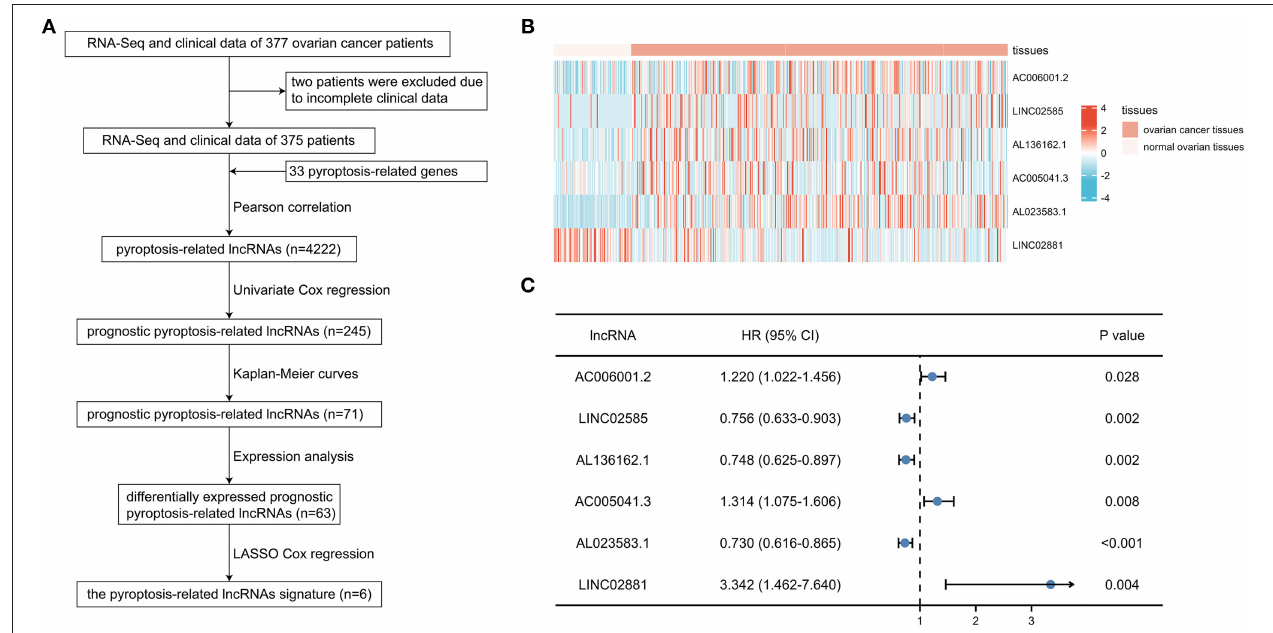
FIGURE 1 | Identification of prognostic pyroptosis-associated long noncoding ribonucleic acids (lncRNAs) in patients with ovarian cancer (OC). (A) Flow chart of constructing the pyroptosis-related lncRNAs signature. (B) Heatmap of 6 prognostic pyroptosis-related lncRNAs in OC tissues and normal ovarian tissues. (C) Univariate Cox regression of 6 prognostic pyroptosis-related